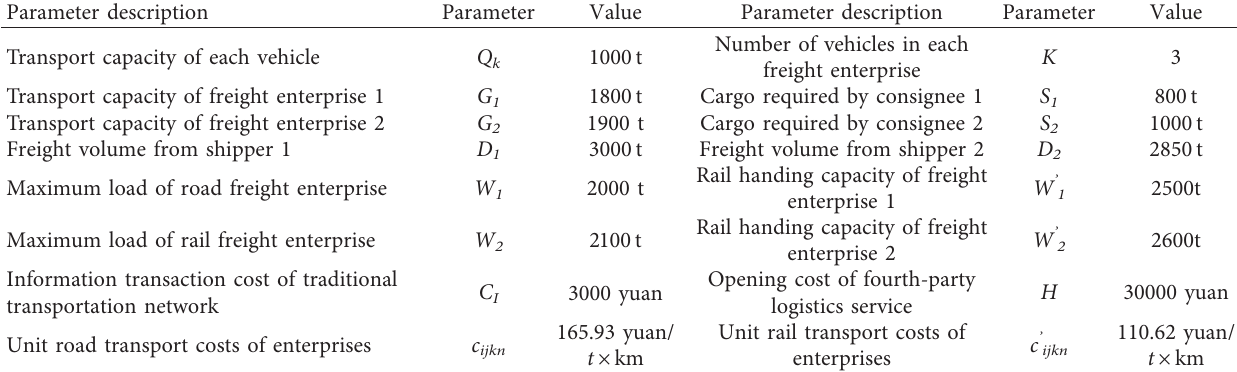
Table 2: Parameter of the small bulk cargo transport network.